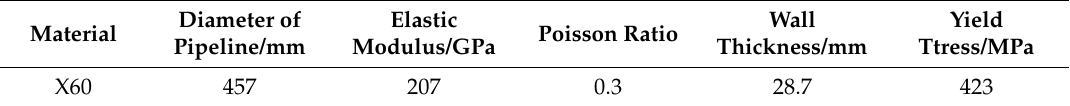
Table 5. Basic parameters of pipeline